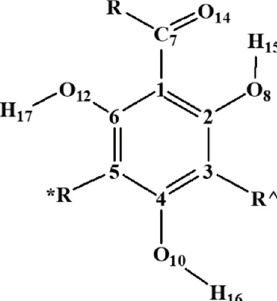
Figure 1. General structure of monomeric acylphloroglucinols and atom-numbering utilised for each monomer. R is the alkyl chain of the R − C=O group of the given molecule; R^ and R* denote possible substituents in meta to the R − C=O group. In trimeric acylphloroglucinols (Figure 2), the R^ of the first monomer, the R* of the third monomer, and both R^ and R* of the inner monomer, are replaced by methylene bridges. The first atom of R^ is given the number 9, the first atom of R* is given the number 11, the first atom of R (after C7) is given the number 13, and the second atom of R (if present) is given the number 19.